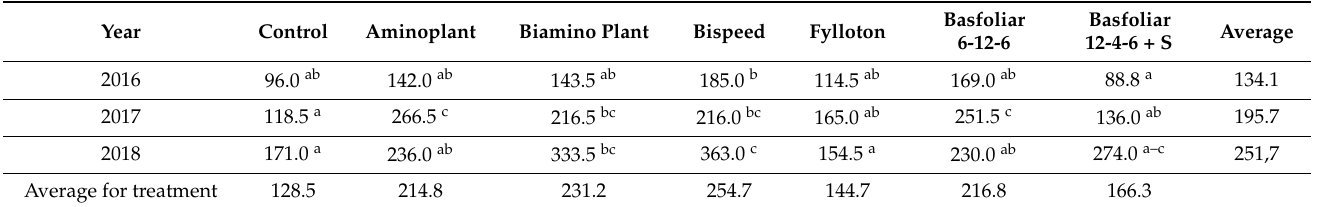
Table 5. The fresh weight of M.9 rootstock stooling leaves depending on the tested treatments